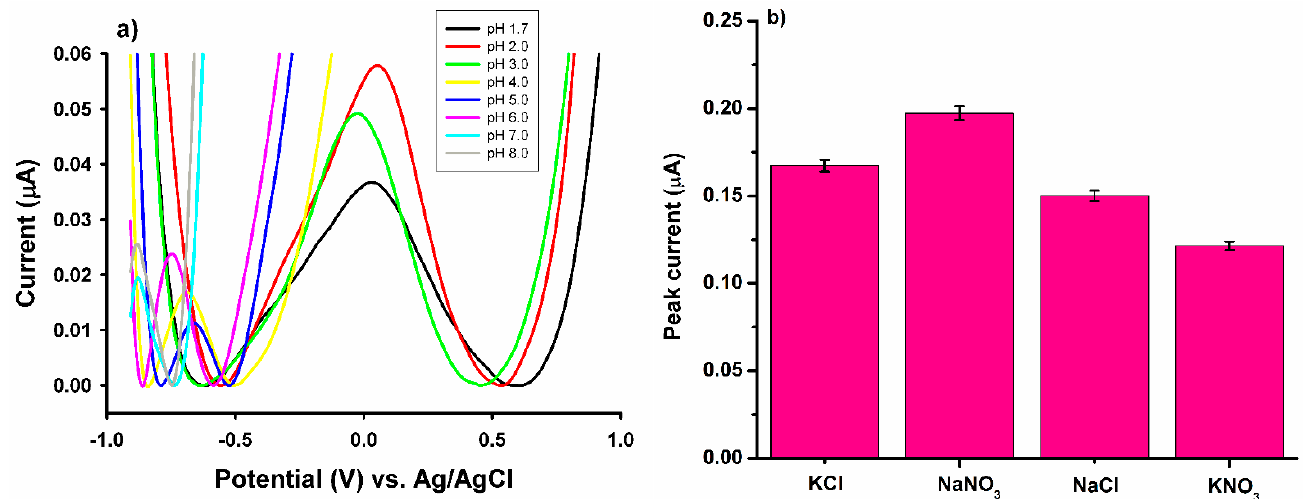
Figure 6. ( a ) DPVs of 10 -4 mol L -1 thiamine in the PIXCoCl/AuNPsnGr in PBS at pH values of 1.7,